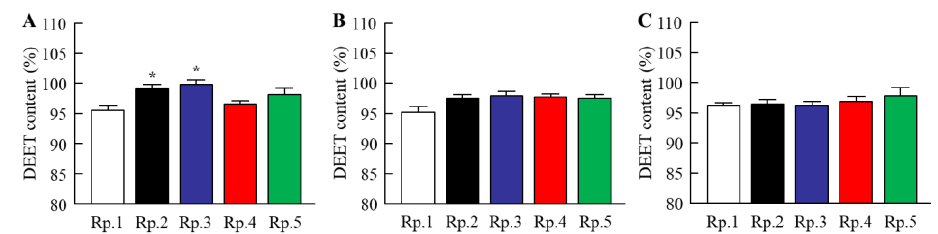
Figure 3. Changes in drug adsorption on polypropylene in the DEET/EtOH/CD (10:40:0.1%) formu- lations at 4 °C ( A ), 25 °C ( B ), and 50 °C ( C ). The compositions of DEET/EtOH/CD formulations (Rp. 1–5 formulations) are shown in Table 1, and the DEET/EtOH formulations were stored for 3 weeks. n = 8. * p < 0.05 vs. Rp. 1 formulation for each category. The adsorption of DEET was significantly prevented by the addition of 0.1% β - CD and HPβCD at the 4 °C condition. On the other hand, no significant difference in drug adsorption was observed in the DEET/EtOH formulations with or without CDs at 25 °C and 50 °C.